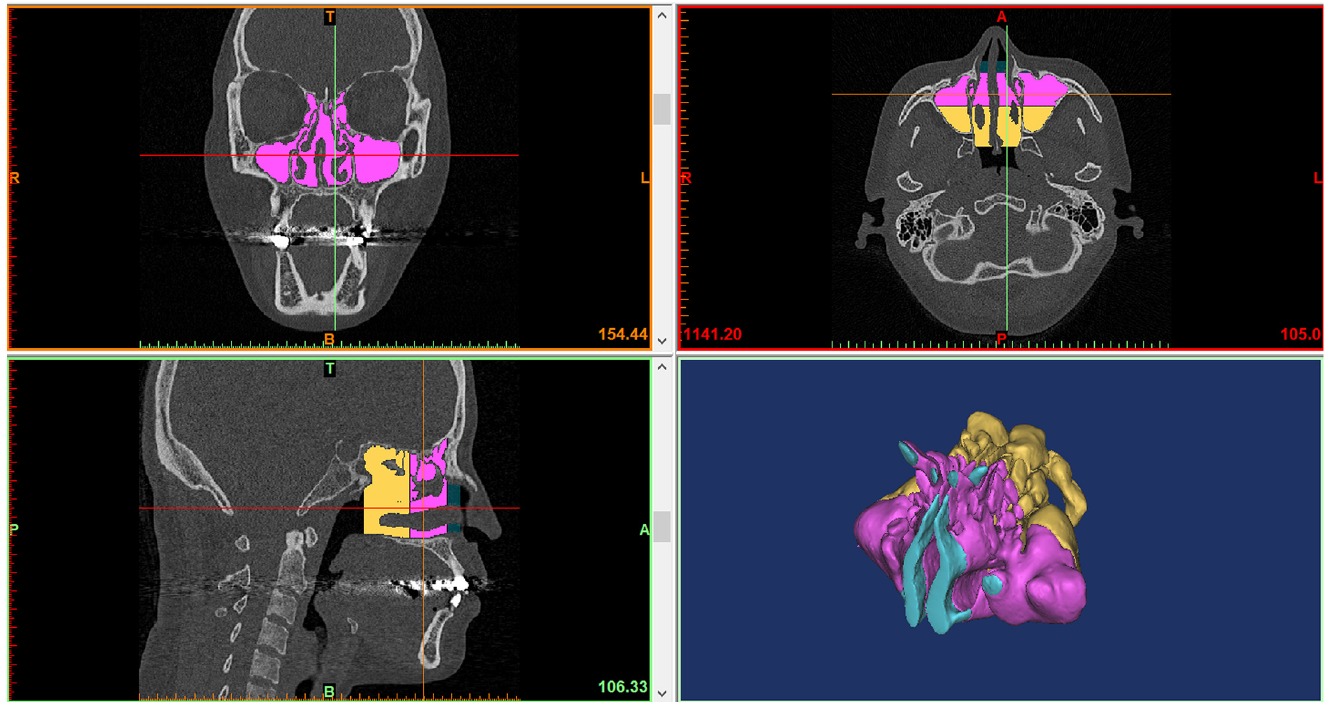
Fig 1. Nasal cavity volume measurement using Mimics 1